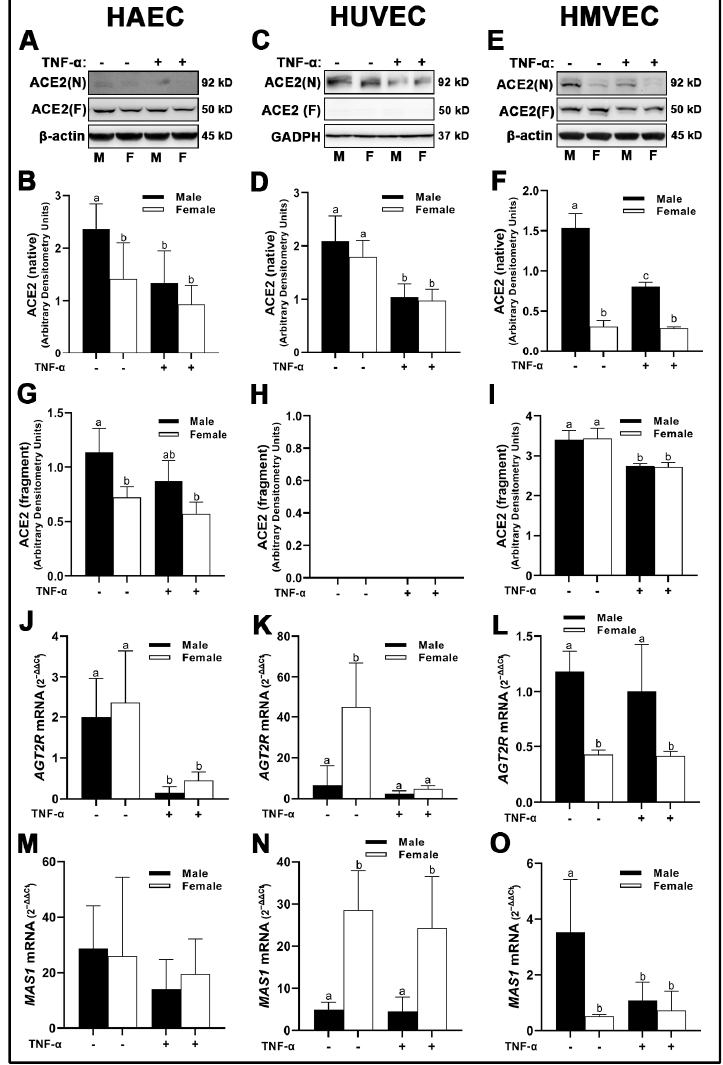
Figure 3. Expression of protective RAS components in male and female endothelial cells. HAECs, HUVECs and HMVECs were cultured in starvation medium at ~80% confluency for 24 h with or without TNF- α (20 ng/mL). Protein expression of ACE2 ( A – I ) were determined by Western blot. Quantification was performed using Image Lab (Bio-Rad Laboratories, Inc.). Protein was normalized to respective control bands ( β -actin or GAPDH). Gene expression of AT 2 R ( J – L ) and Mas receptor ( M – O ) were determined with qPCR. Genes of interest were normalized to housekeeping gene cyclophilin. Data are expressed as mean ± SD from 4–6 experiments. Data were statistically analyzed with one-way ANOVA followed by Tukey post hoc multiple comparison analysis between groups. Values that do not share the same letter are significantly different from each other ( p ≤ 0.05).